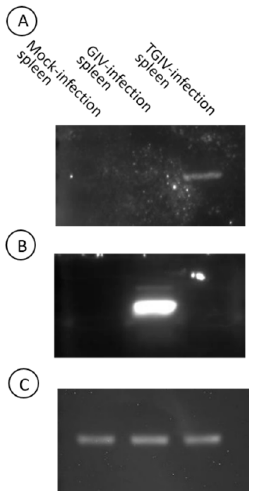
Figure 3. Detection of MCPs in TGIV and GIV infected tissues with specific polyclonal antibodies. The spleen tissues were collected from morbid fish infected with TGIV or GIV. Cell lysates were subjected SDS-PAGE, transferred to a PDVF membrane, and detected by TGIV-MCP ( A ) and GIV MCP ( B ) polyclonal antibodies (5000-fold dilution in PBS), respectively. β -Actin detected with specific monoclonal antibody ( C ) was included as a control.